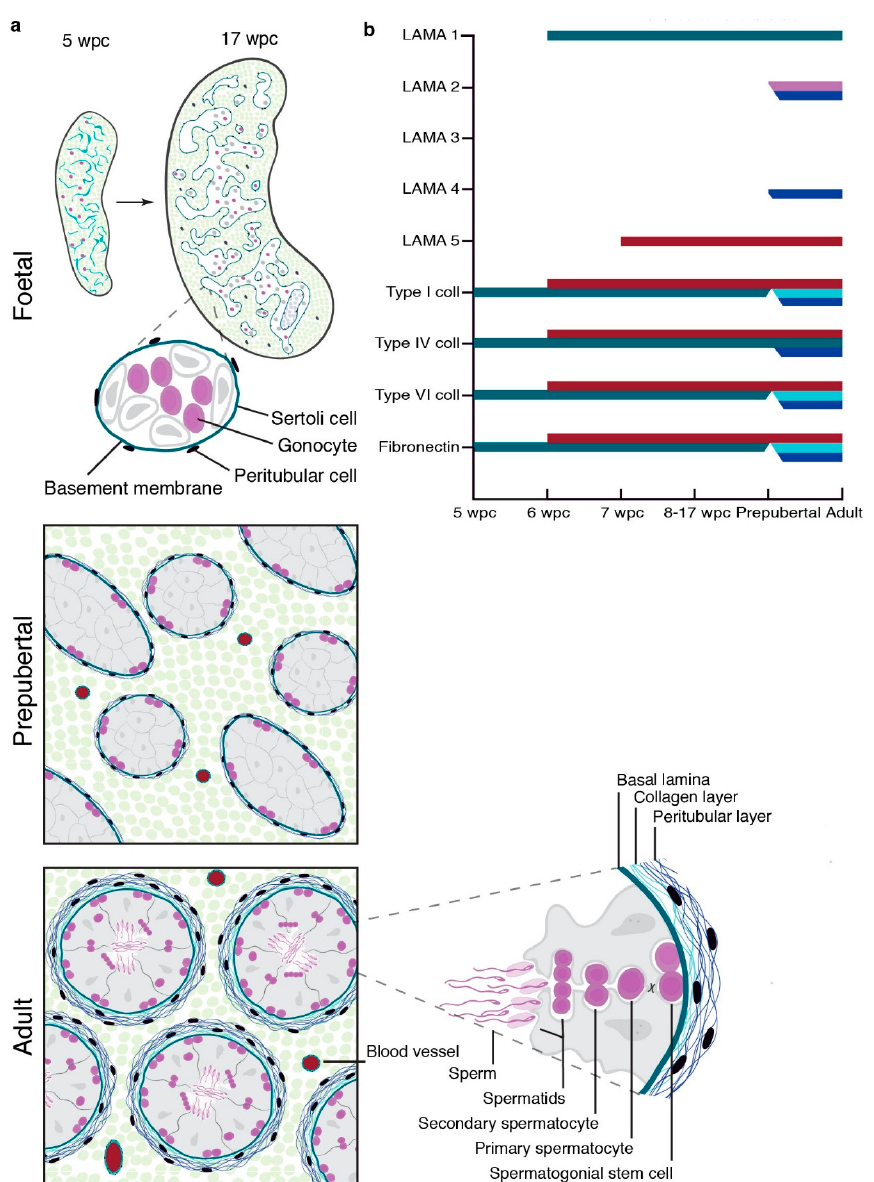
Figure 5. Schematic depiction of testicular LAMA, fibronectin, and collagen expression during gonadal development. ( a ) Establishment of a single-layered seminiferous basement membrane from 5 to 17 wpc, prepubertal, and multi-layered structure of adult seminiferous tubules. ( b ) Onset of LAMA 1, 2, 3, 4, and 5 as well as type I, IV, and VI collagens and fibronectin expression in prenatal first and second trimester gonads, as well as their expression pattern in prepubertal and adult testicular tissue. Colour coding: Basal lamina (green), collagenous BM layer (light blue), peritubular BM layer (dark blue), spermatocytes (pink), and vasculature (red).